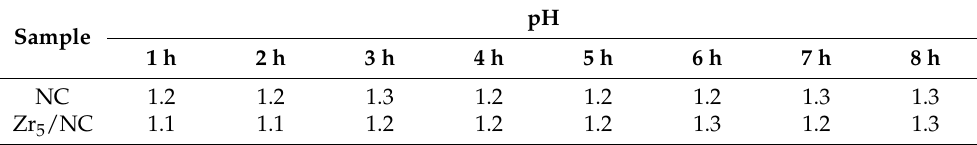
Table 1. pH of NC and Zr 5 /NC at different time intervals during the acetylene dimerization reaction.